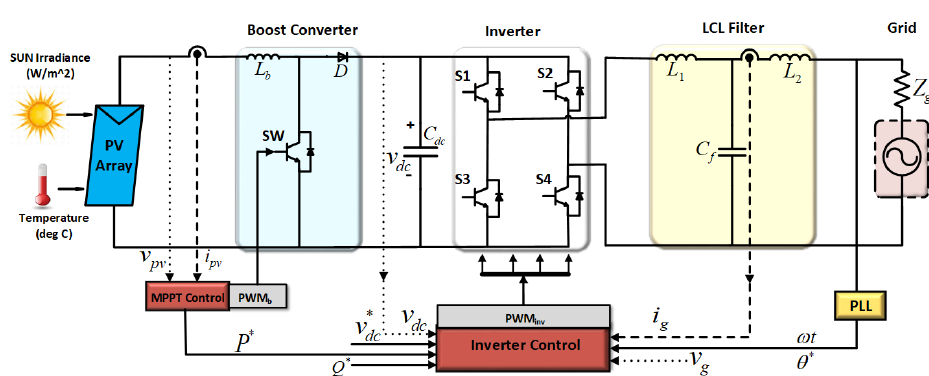
Figure 1. Block diagram of proposed grid-connected PV system with dual